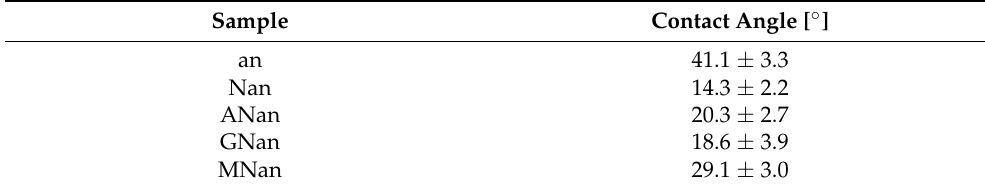
Table 2. Contact angle measurements of the non-modified (an) and modified (Nan, Anan, GNan, and MNan) TiO 2